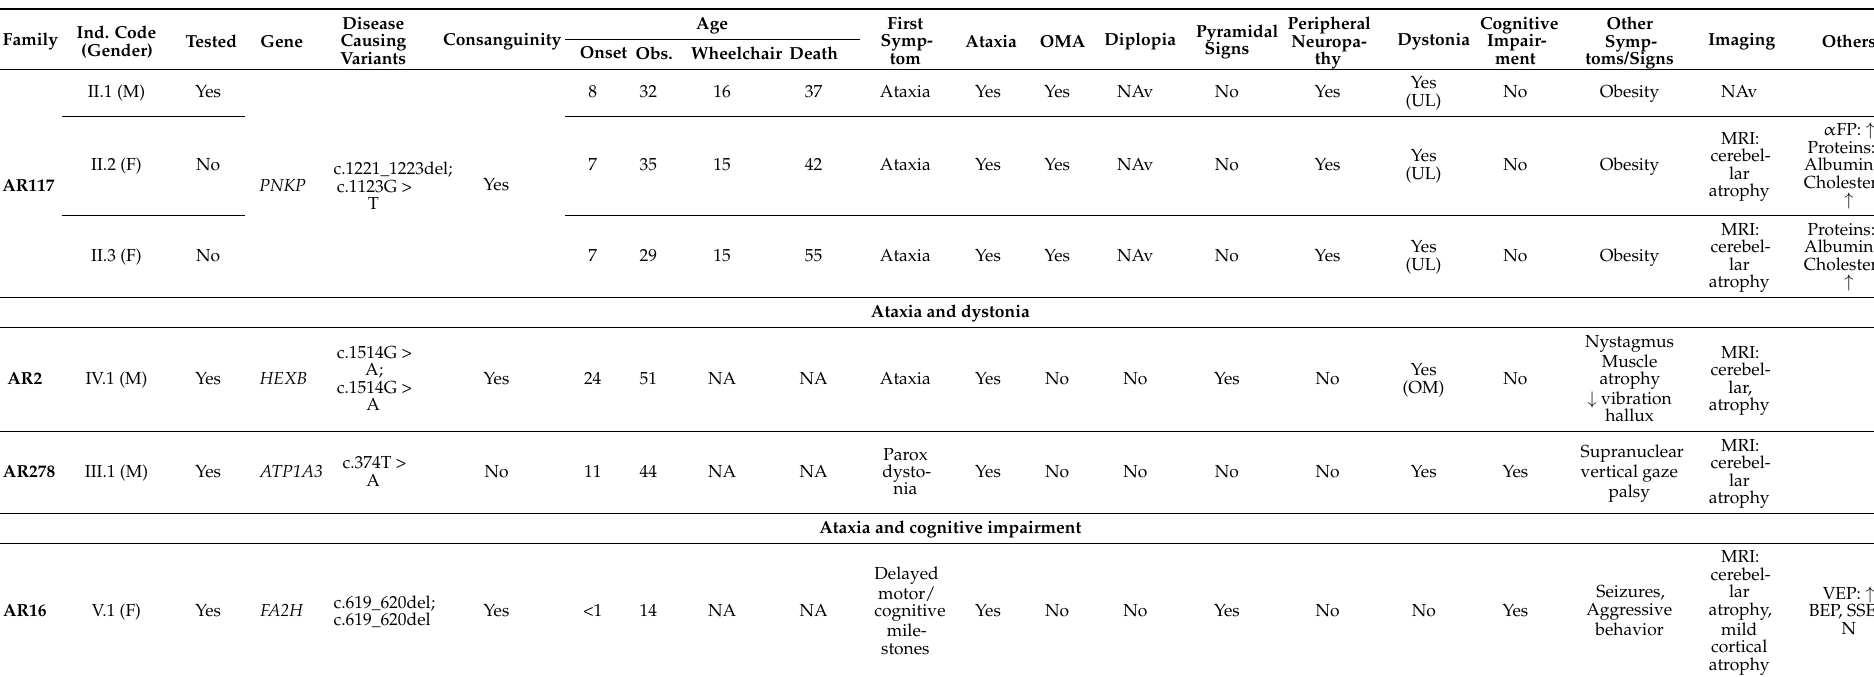
Family Ind. Code